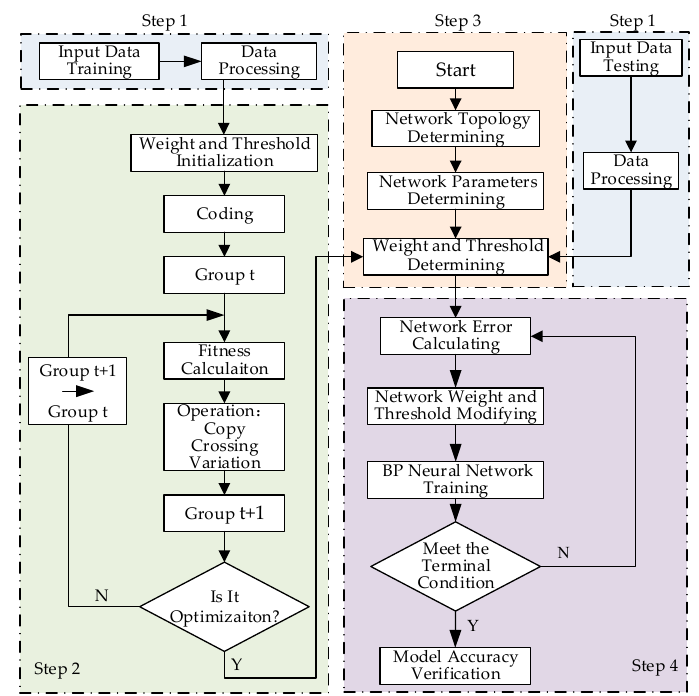
Figure 2. Flow chart of genetic algorithm (GA)-BPNN.